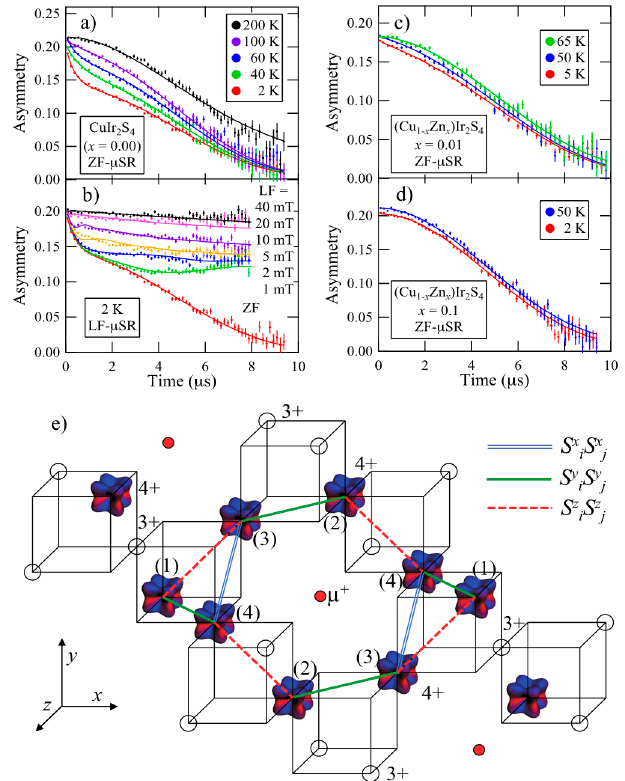
Figure 18. ( a ) Time-dependent µSR spectra observed at several temperatures in a powder sample of CuIr 2 S 4 under zero external field. ( b ) µSR spectra at 2 K under various longitudinal fields. µSR spectra in Cu 1 − x Zn x Ir 2 S 4 under zero external field with Zn contents of ( c ) x = 0.01 and ( d ) x = 0.1. ( e ) Octamer configuration associated with charge order in CuIr 2 S 4 . The exchange interaction S y i S y j for each Ir 4+ pair is shown by a line along the relevant γγ bond ( γ = x, y, z). The octupolar manifold at each Ir 4+ site represents the spin density profile in a hole with an isospin-up state (an eigenstate of the J eff = 1/2 multiplet under strong spin-orbit interaction). The bond lengths of the (1)–(4) and (2)–(3) Ir 4+ pairs are reported to shrink by 15% upon charge ordering and the associated structural transition [36].